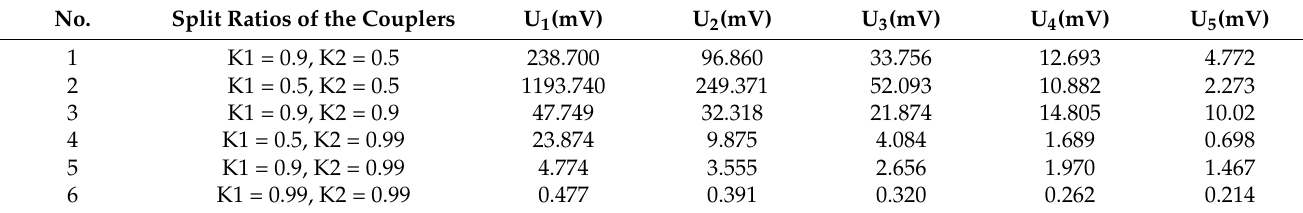
Table 1. The detected signal results under different collocations of the couplers.